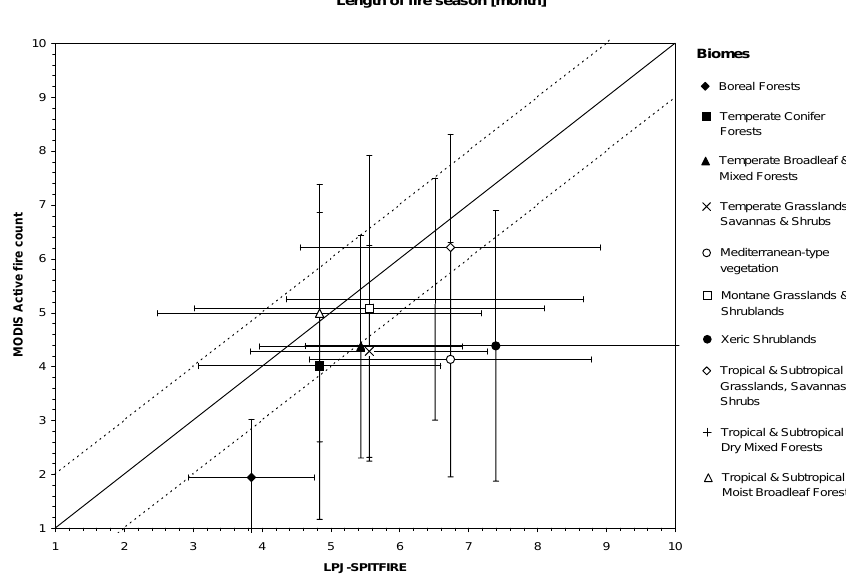
Fig. 6. Observed (MODIS) versus simulated fire season lengths for